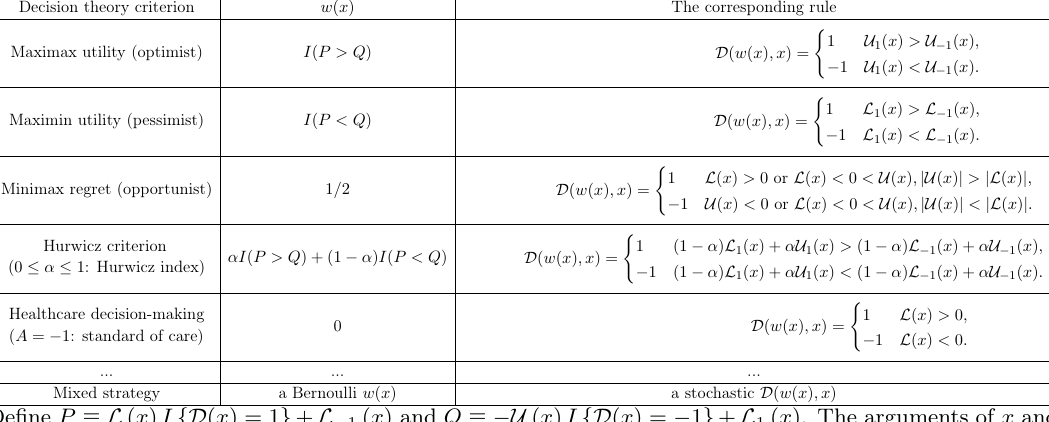
Table 1. Different representations of w ( x ) for various decision-making